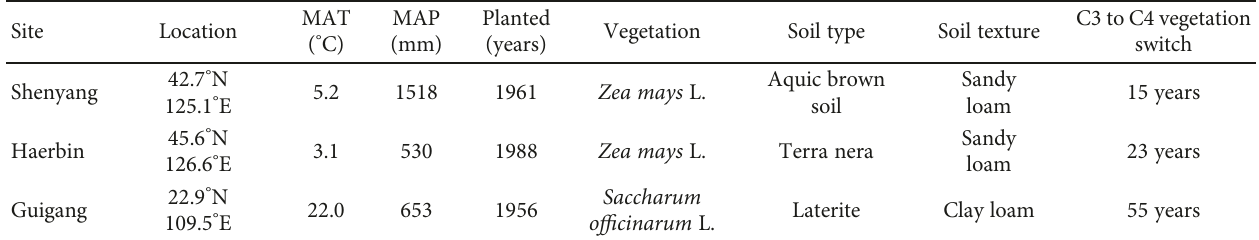
Table 1: Site information.